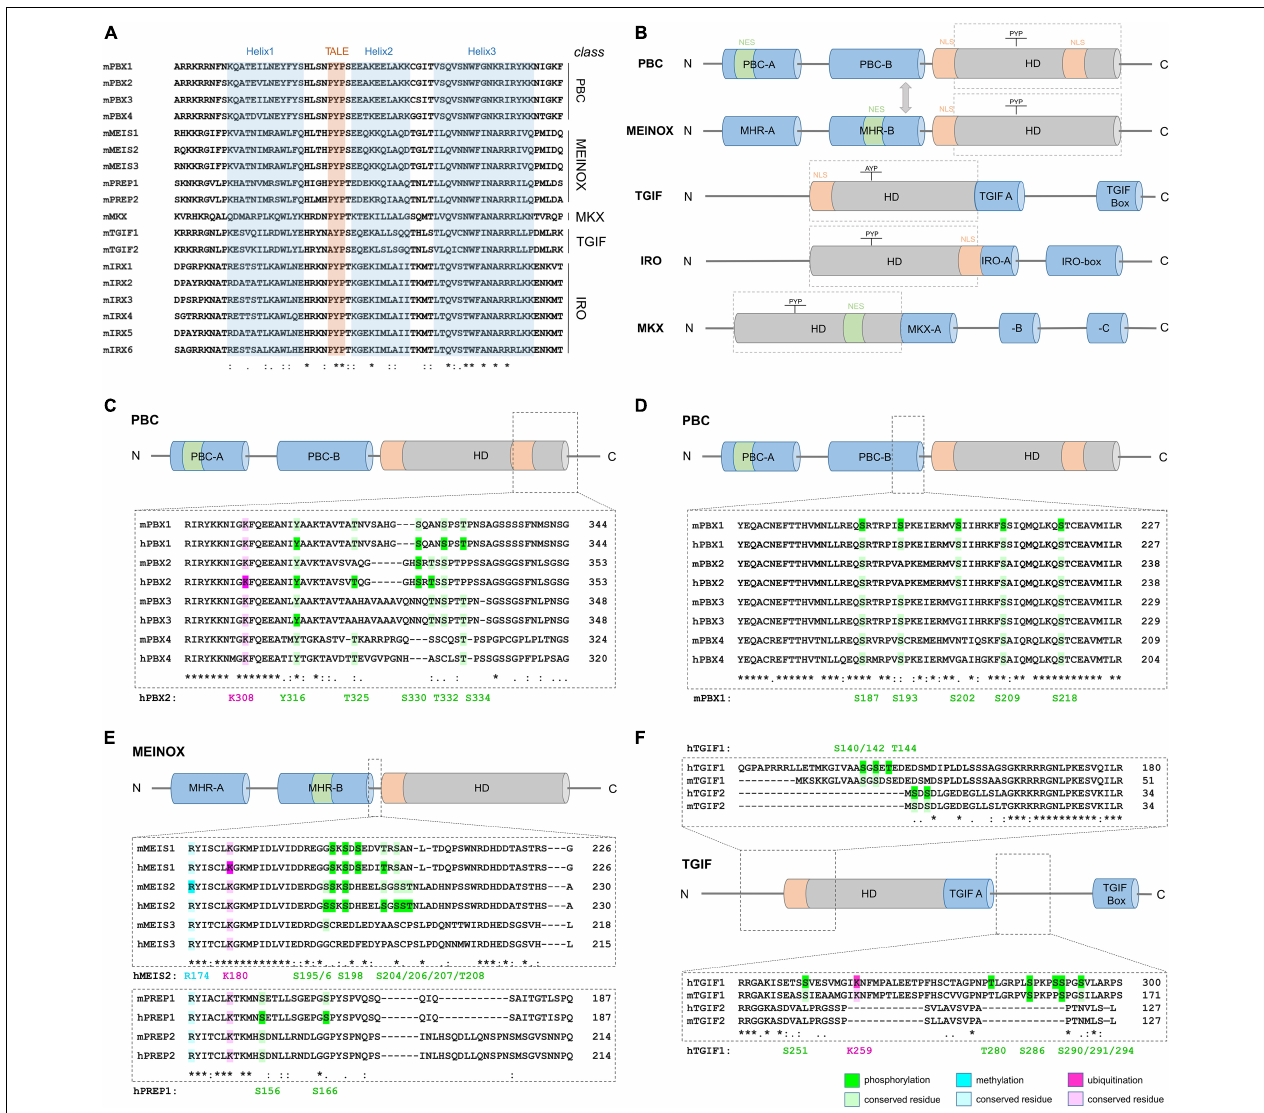
FIGURE 1 | Structure of TALE-HD proteins and examples of abundant, class-specific PTMs. (A) Comparison of the amino acid sequence of mouse TALE-HD domains. Helices 1–3 are highlighted in blue, the name-giving TALE-motif in red. (B) Domain structure of the five TALE-HD protein classes. The HD is shown as gray cylinder, conserved protein domains outside the HD in blue; nuclear export signal (NES): green; nuclear localization signal (NLS): orange. See text for details. Domain sizes are not drawn to scale. (C–E) PTM comparison among paralogs and between human and mouse orthologs. (C) Lysine-ubiquitination and serine-, threonine- and tyrosine-phosphorylation C-terminal to the HD in PBC class proteins. (D) Serine-phosphorylation in PBC class proteins N-terminal to the HD. (E) Arginine-methylation, lysine-ubiquitination and serine/threonine-phosphorylation in MEINOX-proteins. (F) Ubiquitination and phosphorylation in TGIF-class proteins. Numeration of modified amino acids in reference proteins is shown below each amino acid alignment. Color code: green: phosphorylation, blue: methylation, pink: ubiquitination; dark shades indicate PTMs, bright shades indicate residue conservation. A list of PTMs assessed in PBC, MEIS/PREP and TGIF as well as PTMs detected in IRO and MKX can be found in Table 1